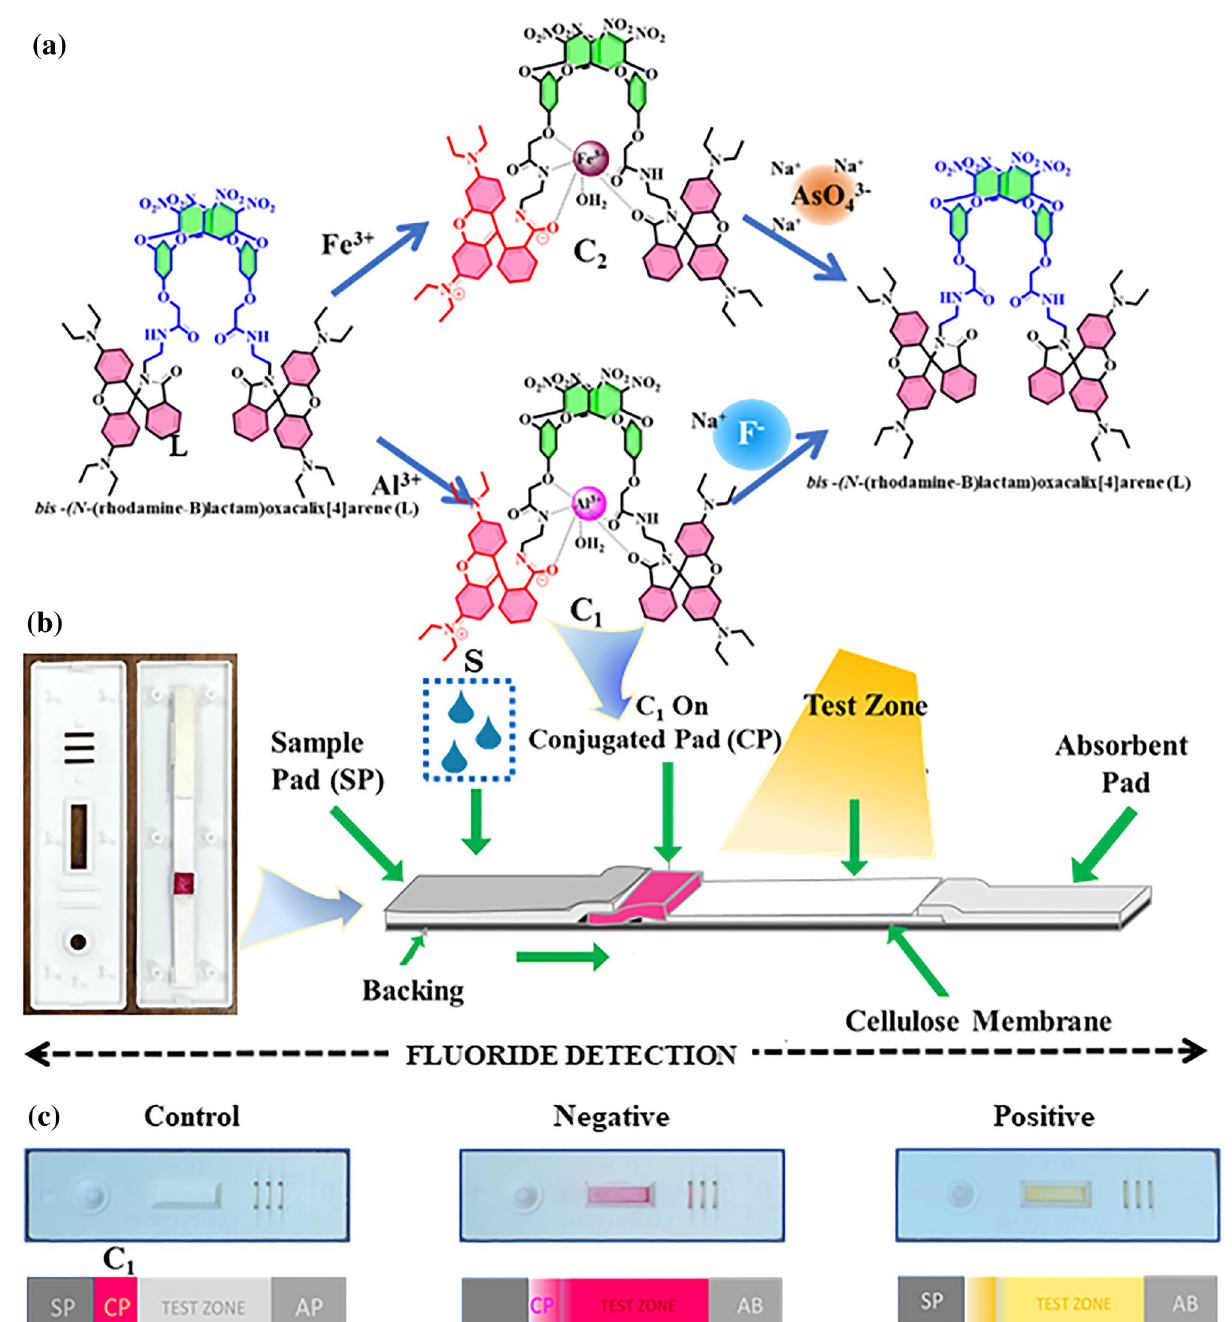
Figure 1. ( a ) Al 3+ /Fe 3+ induced sensing of fluoride and arsenate respectively; ( b ) Schematic illustration of LFA- based PoC device prototype; ( c ) Representation of positive and negative results in LFA toward the detection of